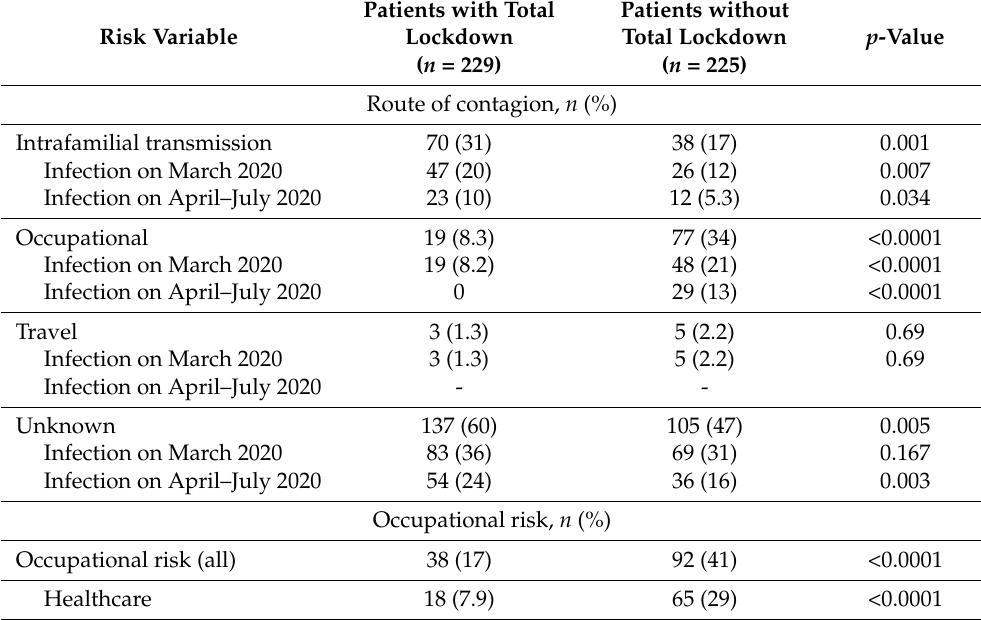
Table 4. Relationship between the route of contagion and occupational risk in patients with and without a total